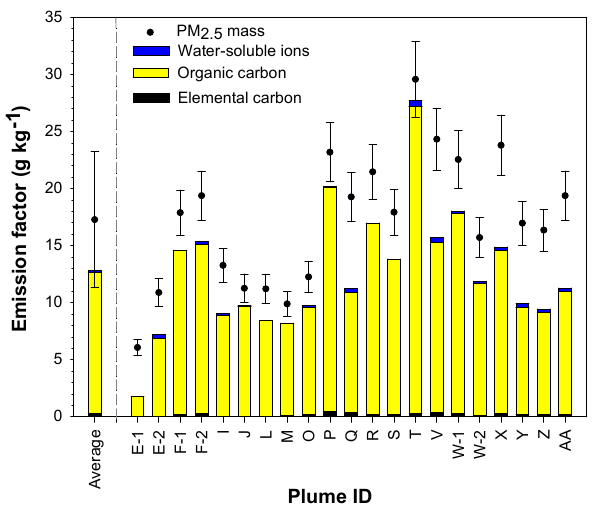
Figure 1. Emission factors of PM 2 . 5 , EC, OC, and water-soluble ions for the average and individual peat smoke plumes. Error bars represent 1 standard deviation of the average or the propagated ana- lytical uncertainty. EF PM was dominated by OC (72%) with mi- 2 . 5 nor contributions from EC (<1%), ions (<1%), and metal oxides (<0.15%, not